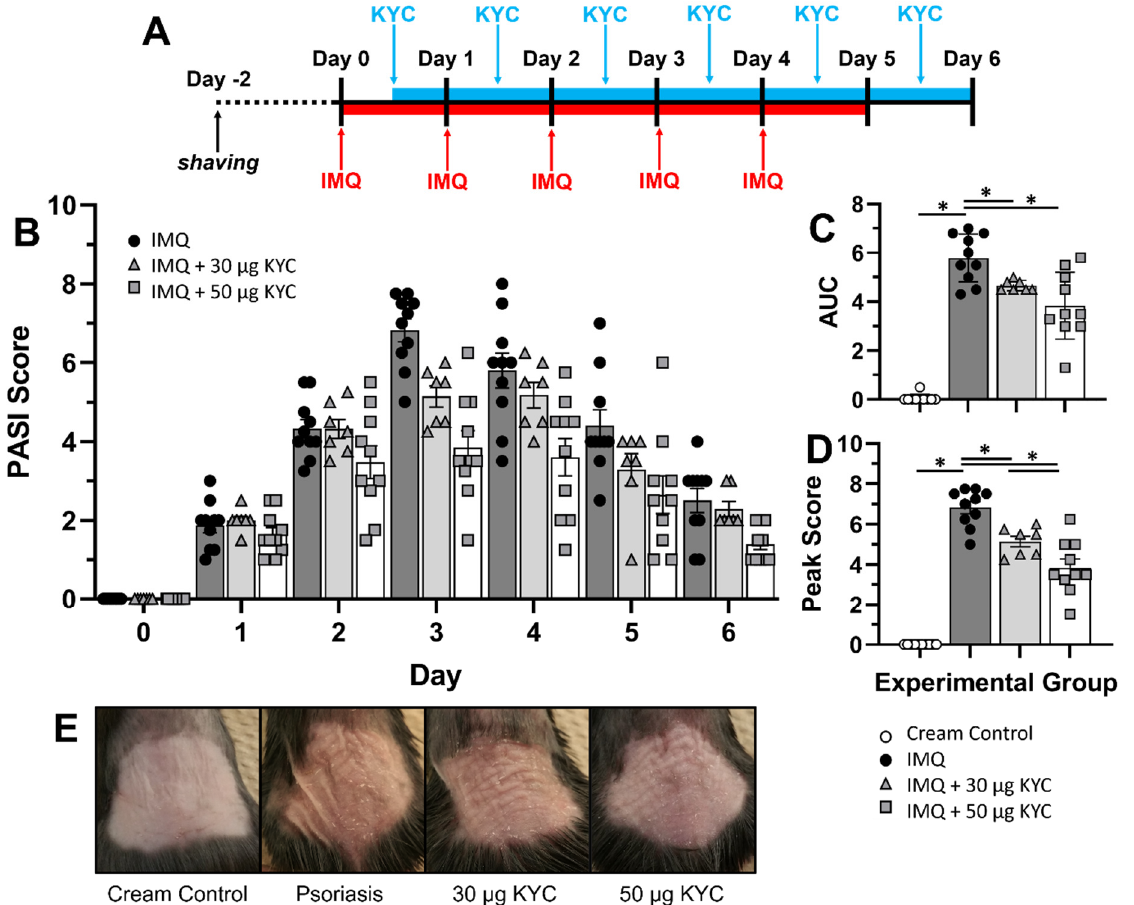
Figure 4. Topical administration of KYC in cream ameliorates plaque psoriasis in mice. Mice were shaved on the back two days before psoriasis induction. At the experiment start, IMQ cream was applied daily for five days in the morning (AM). KYC in cream was administered at least eight hours after IMQ once signs of psoriasis began. Mouse PASI scores were assessed prior to IMQ cream application (AM) and prior to KYC cream treatment (PM); shown are the average scores. ( A ) Experimental timeline and treatment regimen. ( B ) Composite daily PASI scores averaged between AM and PM treatments are shown. ( C ) AUC from the entire disease course was calculated from the daily scores. ( D ) Peak psoriasis incidence on Day 3 (AM + PM) was isolated for comparing treatment groups. ( E ) Representative skin images were recorded at peak psoriasis (Day 3). Cream control = white circles; IMQ psoriasis = black circles; IMQ + 0.3 mg/kg KYC = gray triangles; IMQ + 3 mg/kg KYC = gray squares. Each data point represents one mouse. Data shown are the mean and SEM ( B – D ). Data include two replicate experiments containing 3–4 mice per group. * p ≤ 0.05.